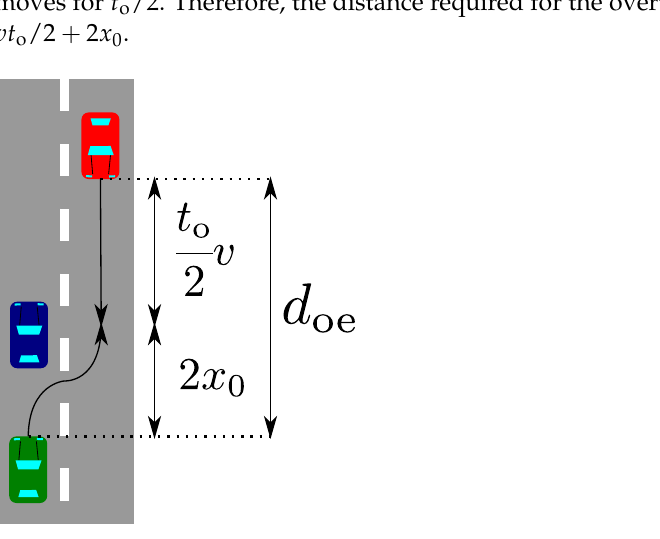
Figure 6. The distance that the ego and oncoming vehicle have moved by the collision of both vehicles. From the above discussion, we combined the distance required for the driving path and the comfortable braking. Figure 7 shows the distance required for comfortable braking and for the three driving path cases. It is shown that the driving path required a larger distance than the comfortable braking distance at a low velocity, and this was reversed at a high velocity. Therefore, considering the driving path is important especially at a low velocity. Namely, the required distance d req can be formulated as follows.